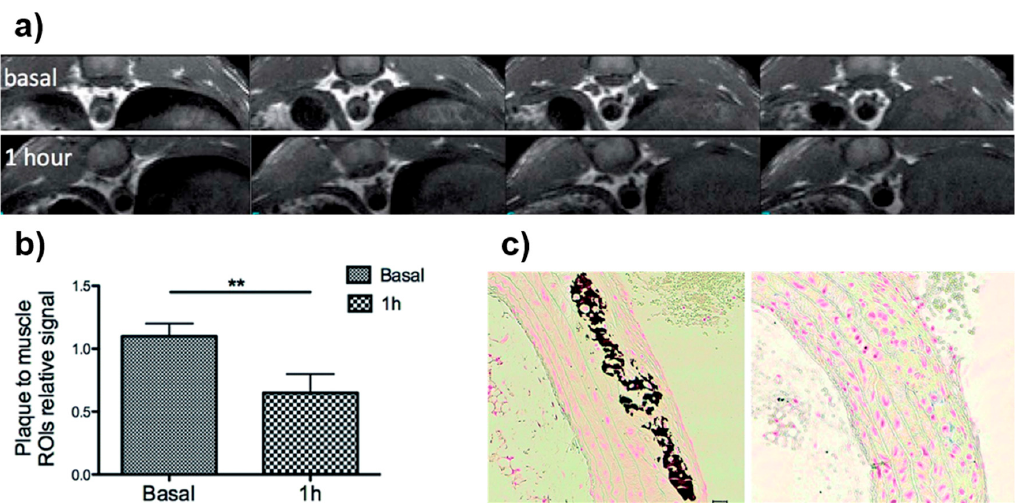
Figure 9. ( a ) In vivo MRI of ApoE − / − mouse prior to (top) and one hour after the intravenous (i.v.) injection of neridronate-functionalized IONPs (bottom); ( b ) plaque to muscle relative signal intensity prior to (basal) and one hour after the i.v. injection of neridronate-functionaliszed IONPs; ( c ) histology of plaque sections stained with von Kossa and Prussian blue for mineralization and iron detection, respectively, scale bar is 22.2 mm. Adapted with permission from Reference [18].